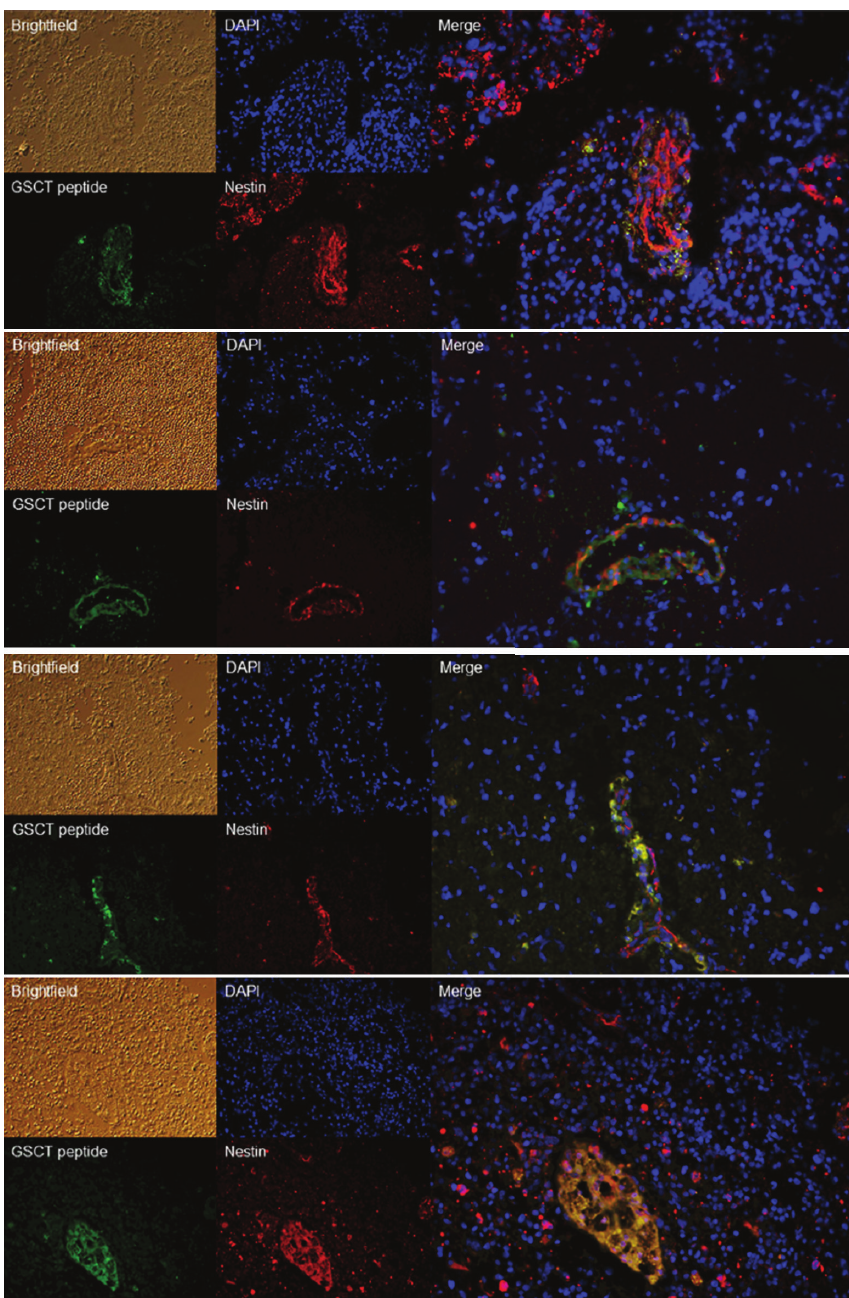
Figure 2: GSCT selectively binds Nestin-positive tumor cells in human GBM tissues. Para ffi n-embedded human GBM tissue sections were stained with a biotinylated-GSCT (B-GSCT) peptide (Green) and Nestin antibody (Red). This immunofluorescence analysis revealed that most B-GSCT peptide-targeting tumor cells are colocalized with Nestin-positive tumor cells [27]. With reprint permission from